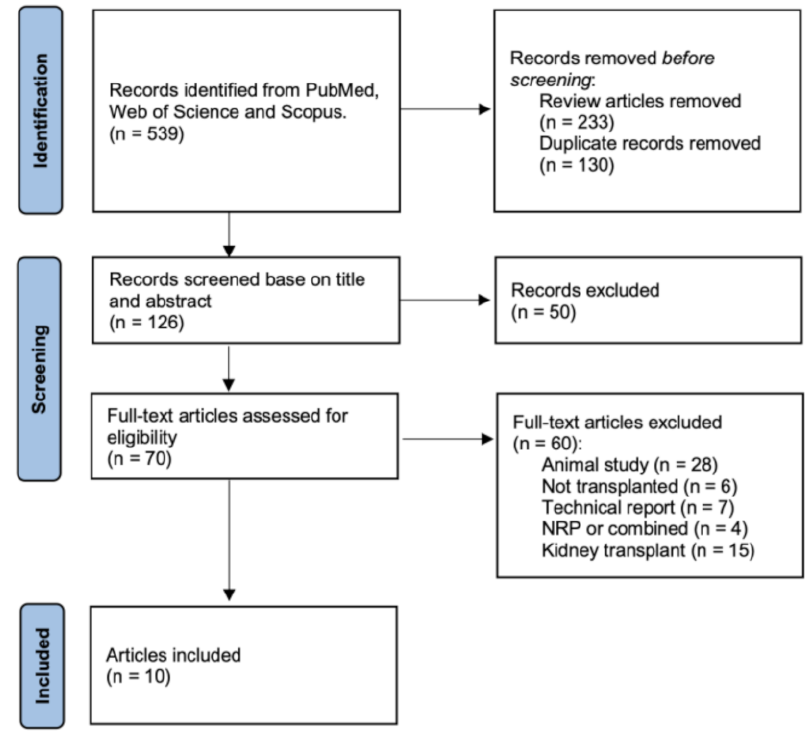
Figure 1. PRISMA flow